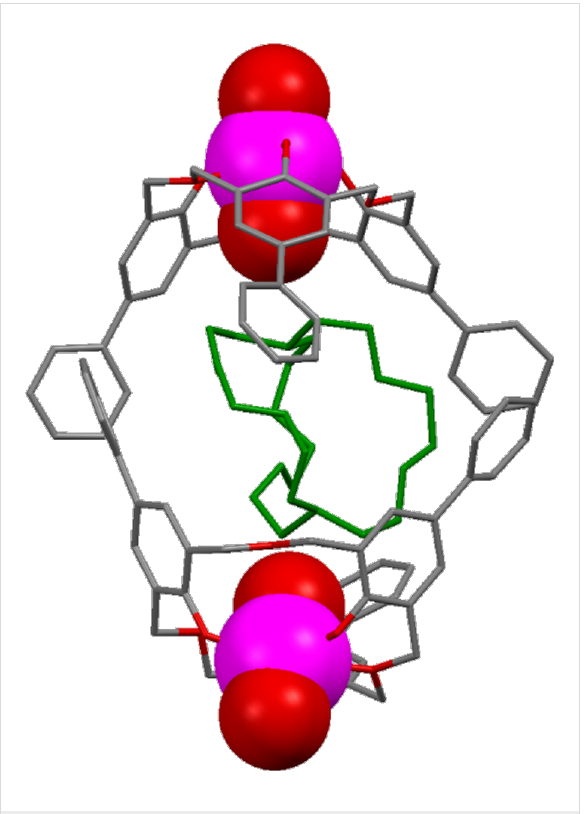
Figure 19: X-ray crystal structure of a supramolecule comprising two [ 3g ·UO 2 ] − complexes that encapsulate a diprotonated cryptand (CCDC ID 181044)